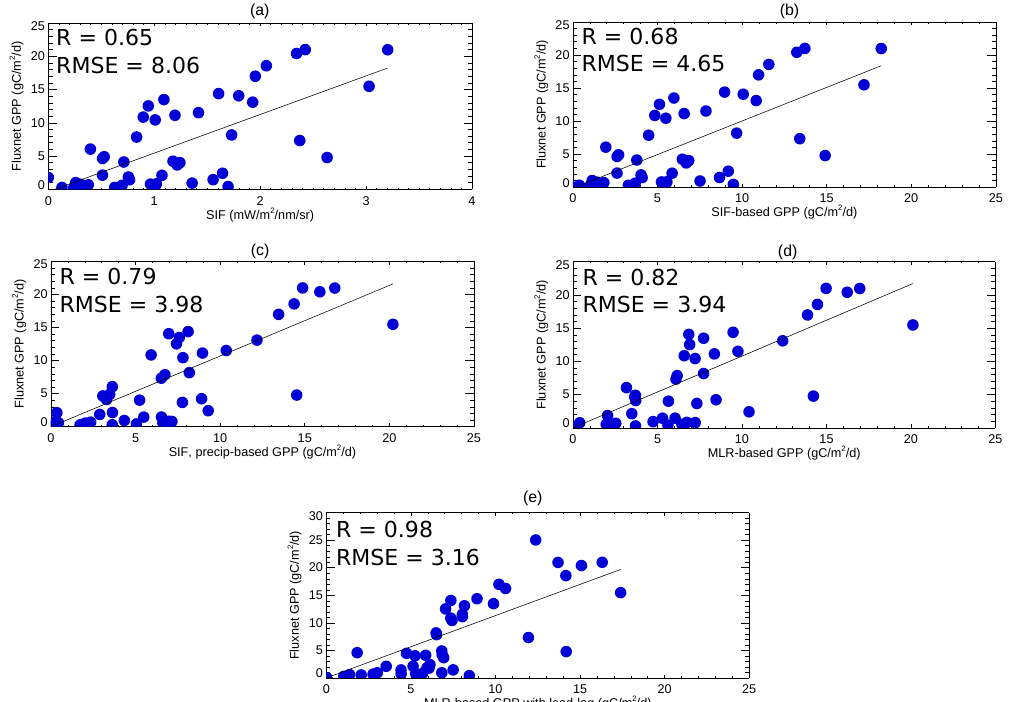
Figure 5. Relationship of mean monthly GPP (gC/m 2 /day) measured at FLUXNET stations with C3 crop vegetation (Table 1) used in this study and ( a ) GOME-2 SIF; ( b ) SIF-based GPP; ( c )